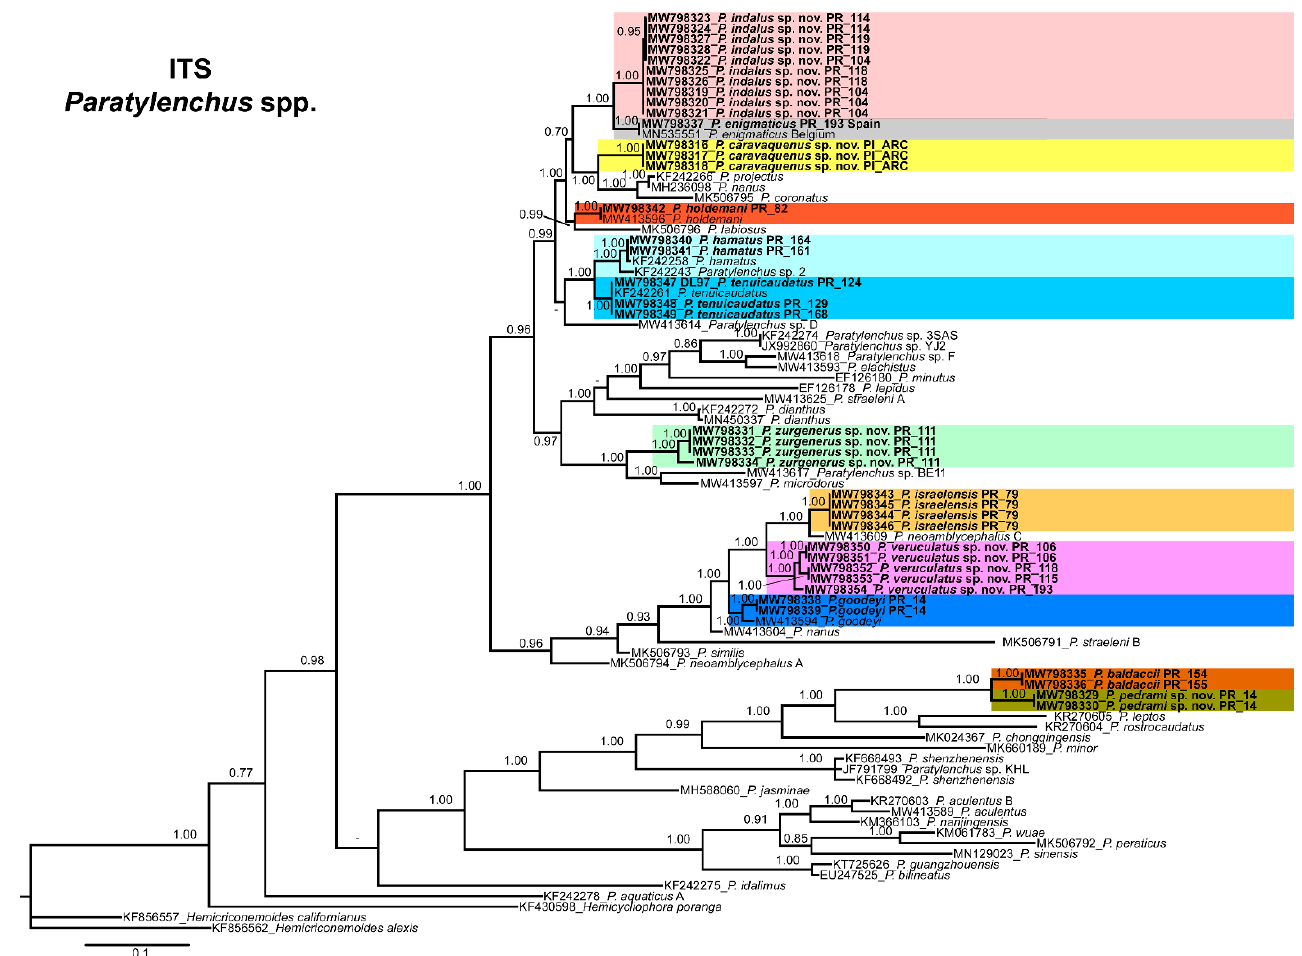
Figure 21. Phylogenetic relationships within the genus Paratylenchus . Bayesian 50% majority rule consensus tree as inferred from ITS rRNA sequence alignment under the general time-reversible model of sequence evolution with correction for invariable sites and a gamma-shaped distribution (GTR + I + G). Posterior probabilities of more than 0.70 are given for appropriate clades. Newly obtained sequences in this study are shown in bold. The scale bar indicates expected changes per